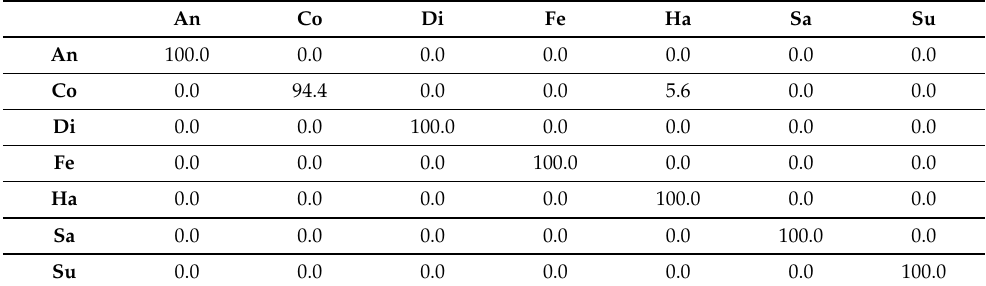
Table 9. Confusion matrix for CK+ database: Weighted summation of modified CNN-based and SVM-based classifiers.